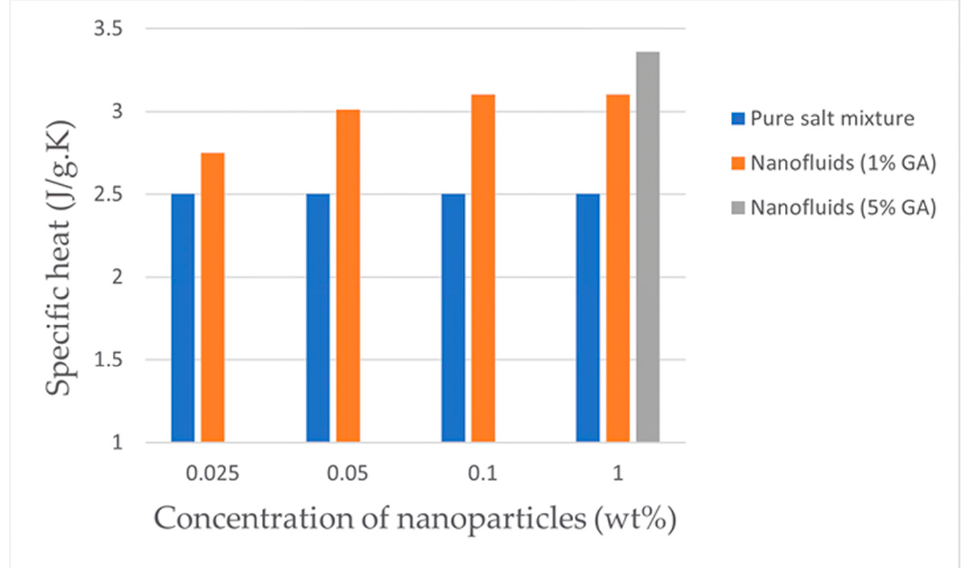
Figure 6. Specific heat of nanofluids in liquid phases with respect nanoparticle concentration [69] .